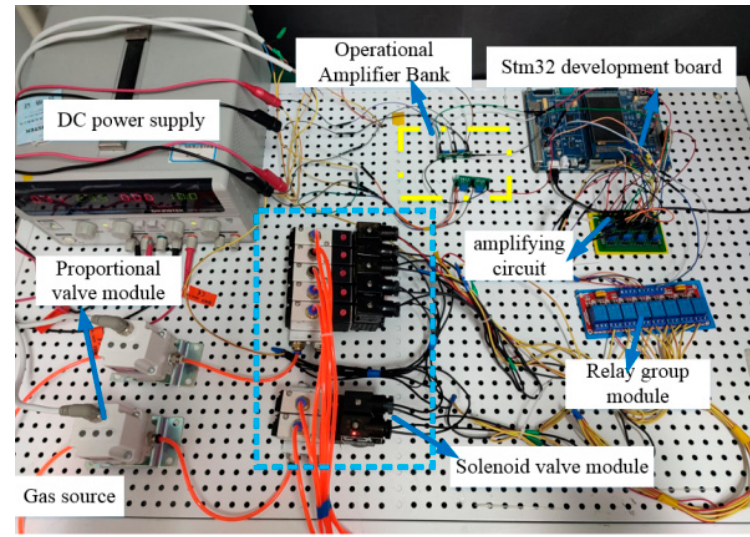
Figure 19. Physical map of the control platform.